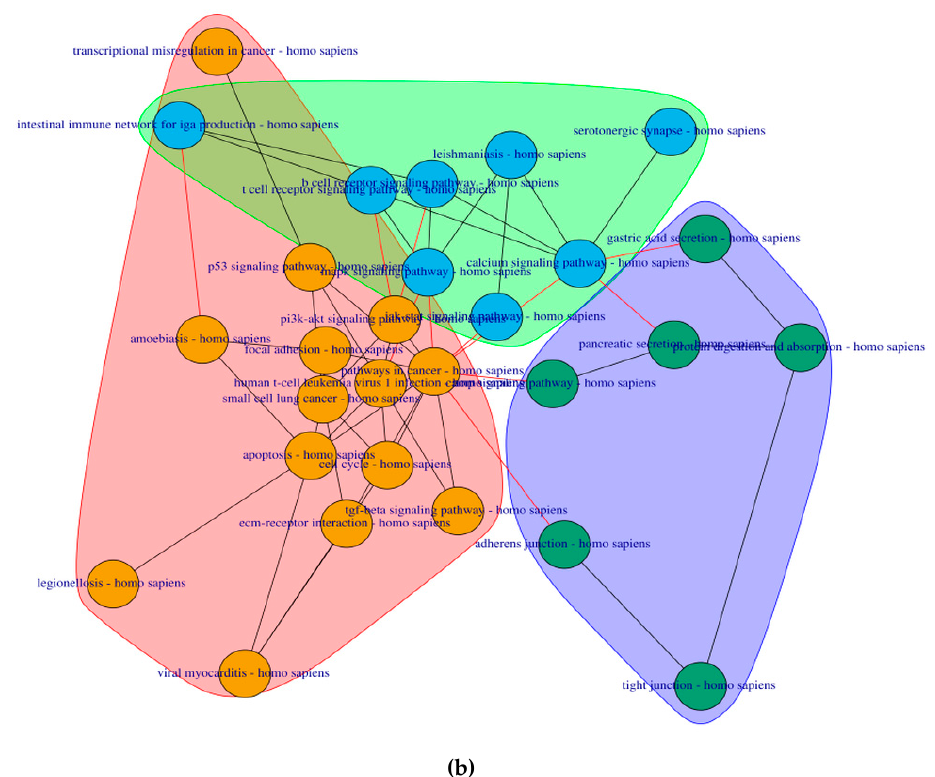
Figure 4. Cluster of connected pathways for pre-symptomatic and symptomatic HD using PathwayConnector ( a ) Clusters of pathways in the pre-symptomatic HD stage. There is a total of six clusters, each shaded in a different color. ( b ) Three clusters of pathways in the symptomatic HD stage. 2.5. GeneTrail3 for the Identification of Pathways by Analysing the DEGs for Pre-Symptomatic and Symptomatic HD Patients The pathways identified by GeneTrial3 for pre-symptomatic and symptomatic HD from each selected biological database are sorted based on the adjusted p -value [17]. The top-15 pathways for pre-symptomatic and symptomatic HD are shown in Table 1 and Table 2 respectively.